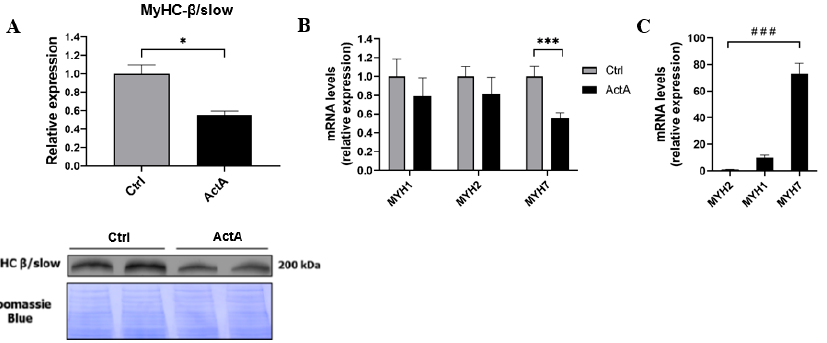
Figure 2. Activin A-induced myotube atrophy is characterized by a decrease in myosin-heavy chain- β /slow content. ( A ) Myosin-heavy chain- β /slow content measured by western blot, 48 h after exposure to recombinant ActA or vehicle. ( B ) MYH1, MYH2 , and MYH7 mRNA levels measured by RT-qPCR, 48 h after exposition to recombinant ActA or vehicle. ( C ) MYH1 , MYH2 , and MYH7 relative expression in differentiated myotubes. Data are reported as means ± SEM (n = 3/condition). * p < 0.05 and *** p < 0.001 vs. Ctrl, ### p < 0.001.